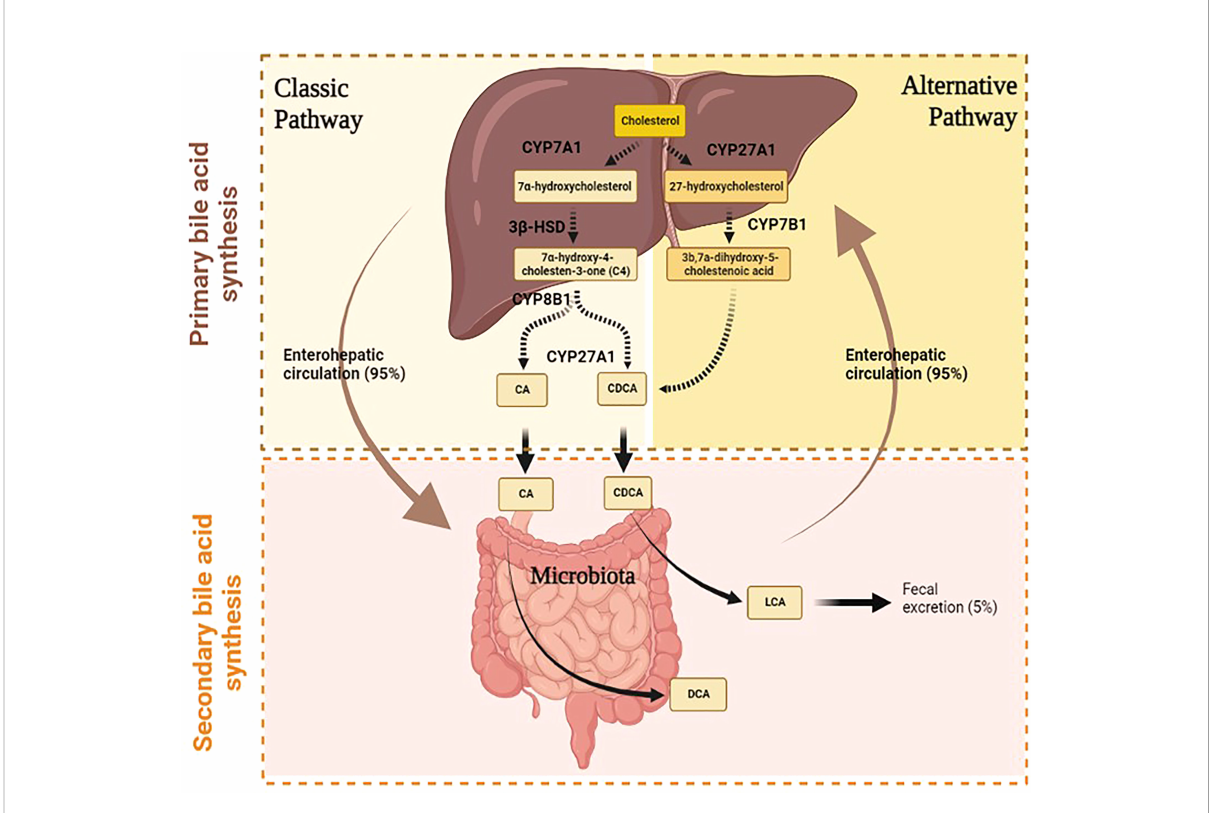
FIGURE 1 Primary and secondary bile acids synthesis in